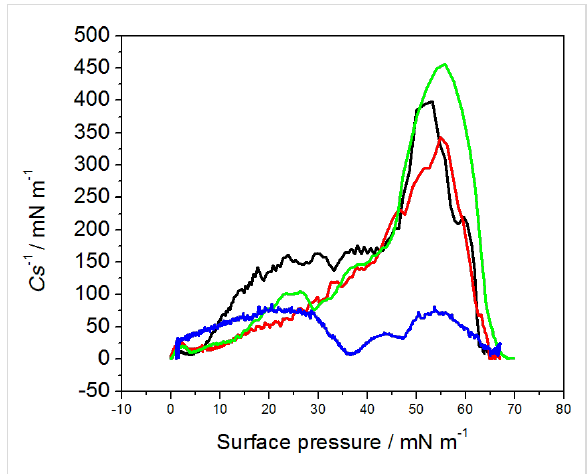
Figure 3: Compression modulus versus surface pressure plot for DPPTE monolayer on water subphase (black), mixed layers of DPPTE/SWCNTs-DNR weight ratio of 1:5 (red), mixed layers of DPPTE/SWCNTs-DNR weight ratio of 10:1 (green), DPPTE mono- layer on subphase containing 10 − 5 DNR